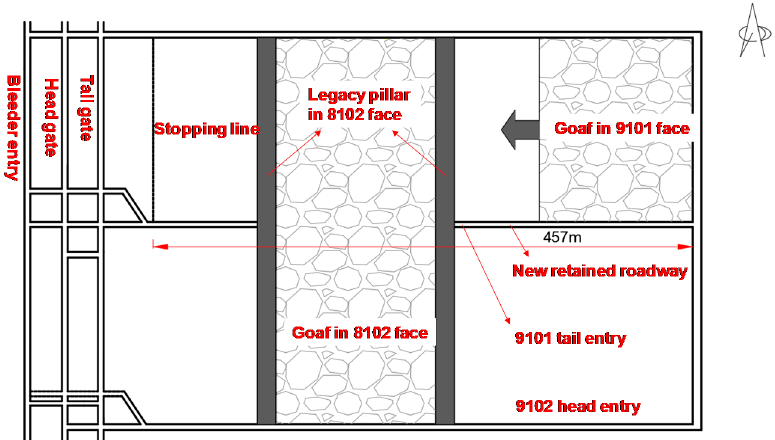
Figure 5. Layout of test working face of GERRCP in Xiashanmao coal mine.